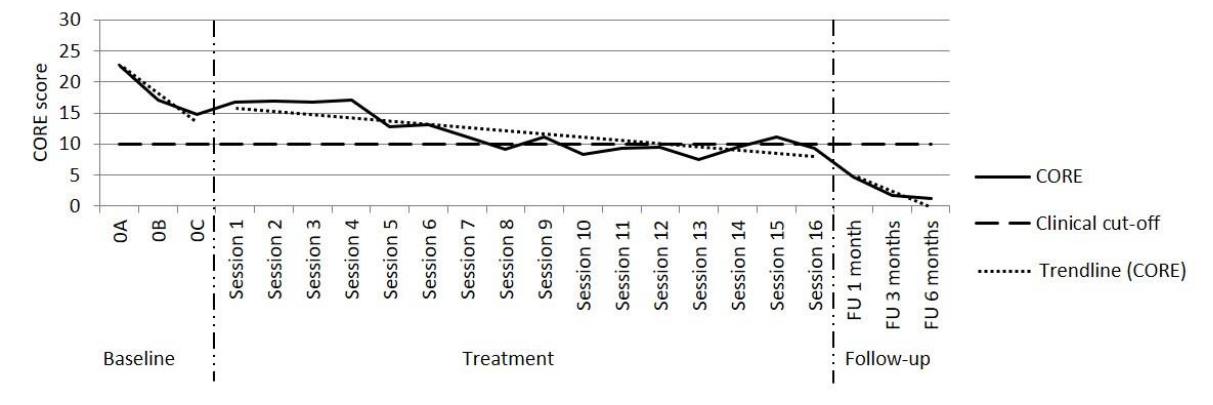
Figure 2: Giorgio’s weekly global distress (CORE) score